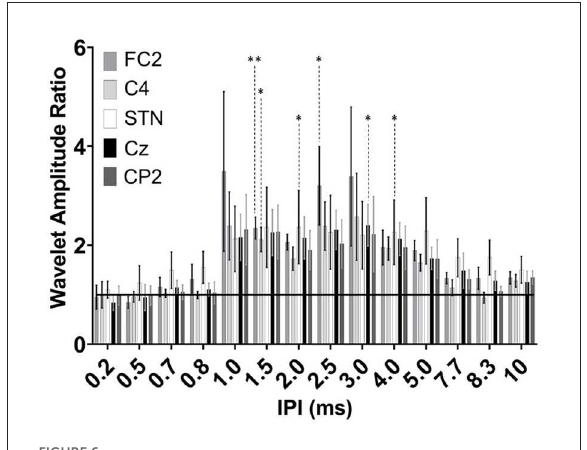
FIGURE6 Group results of wavelet amplitude ratio for the FC2 (dark gray), C4 (light gray), STN-LFP (white), Cz (black), and CP2 (dark gray) at the 0.2–10ms IPIs. Ratio reflects each subtracted IPI over the single pulse condition. Enhancement results in a ratio > 1 and attenuation < 1 with the horizontal black line at a ratio value of one. Significant differences are denoted by the asterisks with P < 0.05 and P < 0.001 (single and double asterisks, respectively) with error bars reflecting the standard error of the